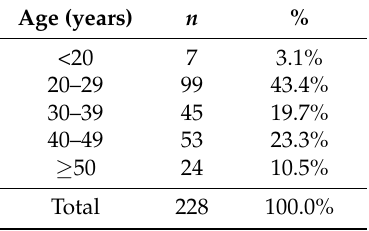
Table 6. Ages of ARES personnel who reported knee injuries ( n = number of injuries).